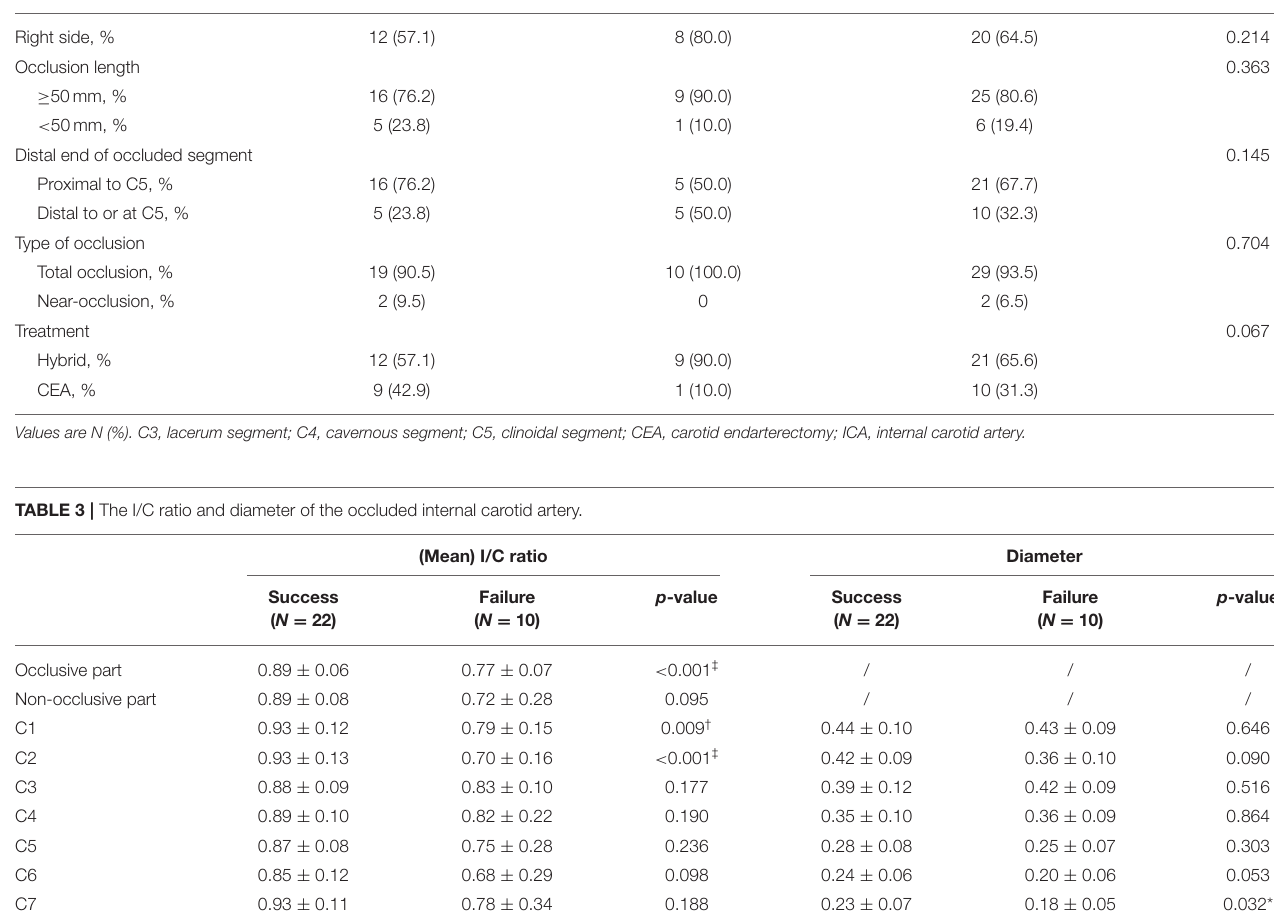
Success cases ( N = 21)